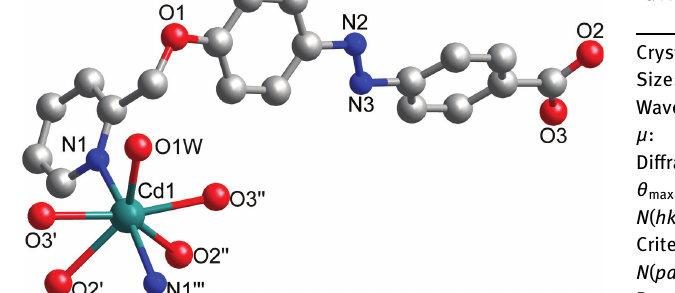
Table 1: Data collection and